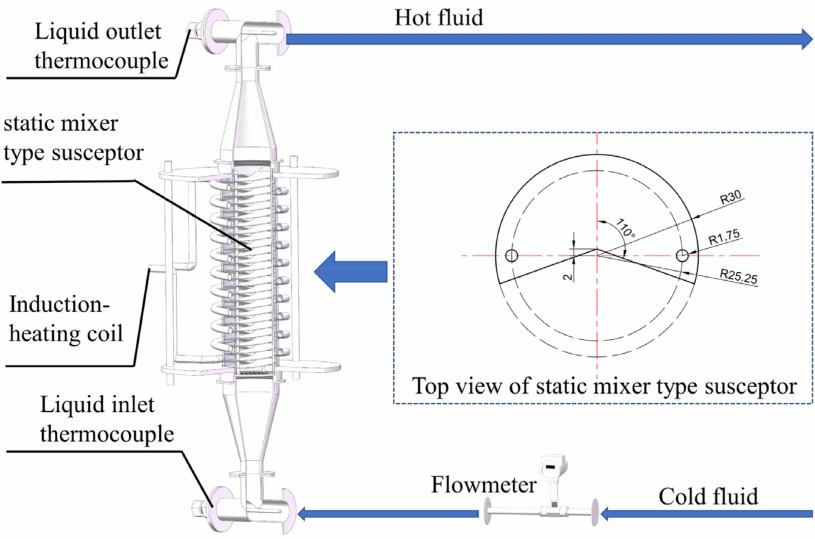
Figure 4. Experimental device diagram of heating flowing liquid by loading static mixer-type susceptor. Table 2. Experimental conditions and results from previous